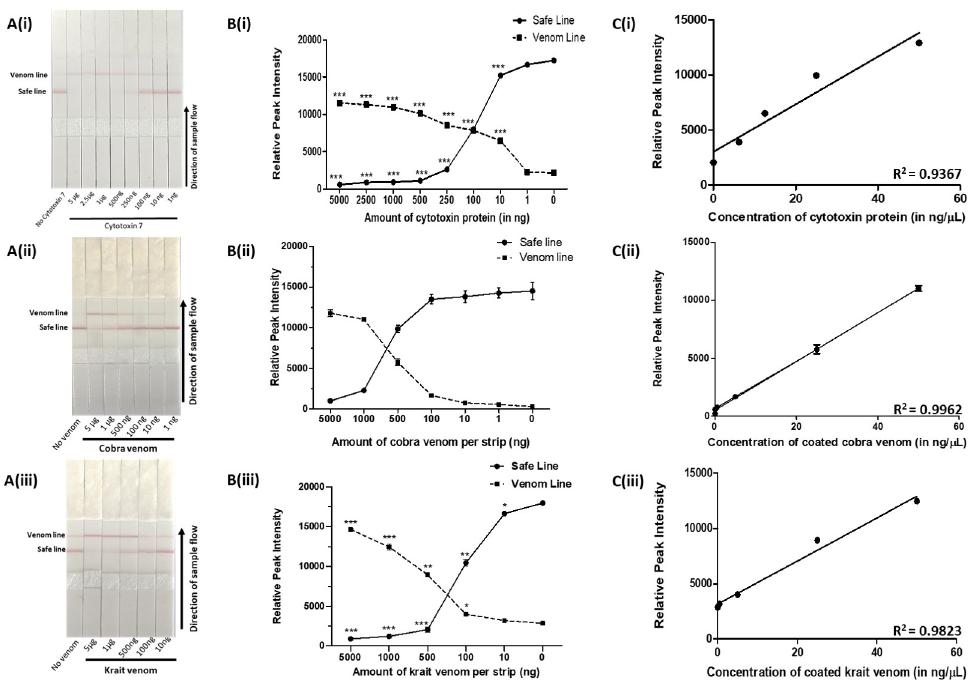
Fig 5. Limit of detection of venoms of N . naja and B . caeruleus by AB1 using the lateral flow assay kit. Panel A . Varying amounts of spiked venom samples were applied onto the strip of the LFA kit and the disappearance of safe line was noted. Panel B . Densitometric analysis of each strip was done using ImageJ and statistical analysis was done for each sample with respect to control ( ��� p < 0.0001). The relative intensities were plotted in a line curve using GraphPad Prism 5. Panel C . The data points encompassing the linear range of detection of respective analytes were fit in a straight line for a non–linear regression curve to determine the limit of quantitation.